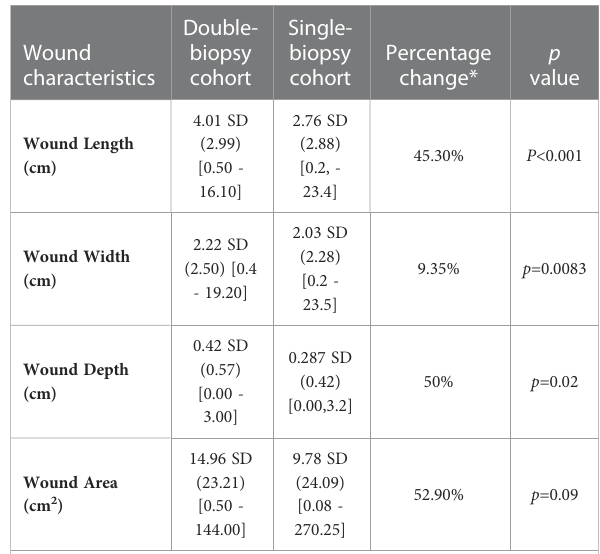
TABLE 2 Comparison of wound characteristics between single and double-biopsy cohorts.